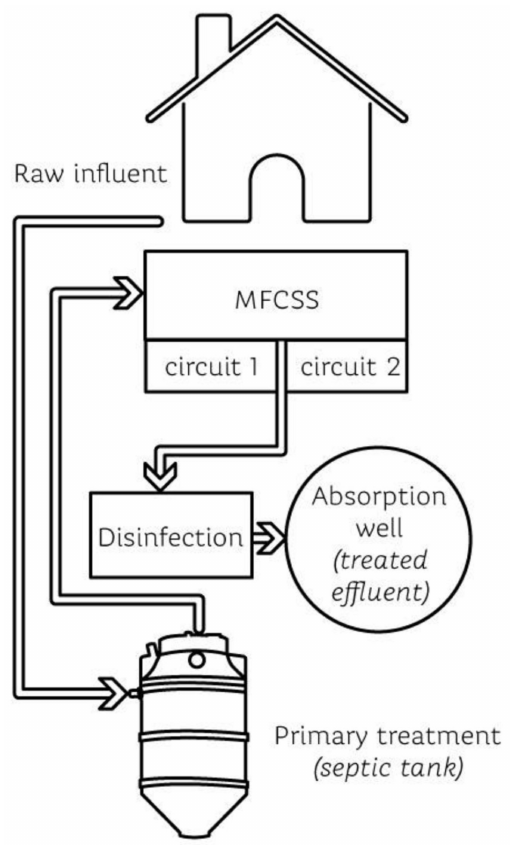
Figure 1. The microbial fuel cell stack system (MFCSS) setup for a real domestic